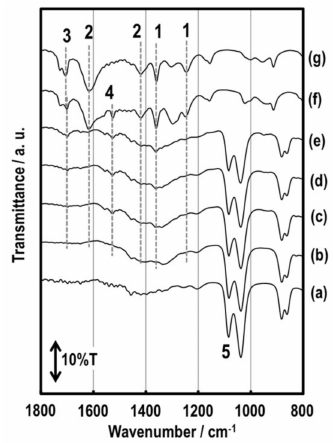
Figure 4. FT–IR spectra of the various solutions and the Sm–Fe precursor solutions without PVP; ( a ) EG only, ( b ) AcAc0, ( c ) AcAc2, ( d ) AcAc4, ( e ) AcAc8, ( f ) metal nitrates with AcAc, and ( g ) AcAc